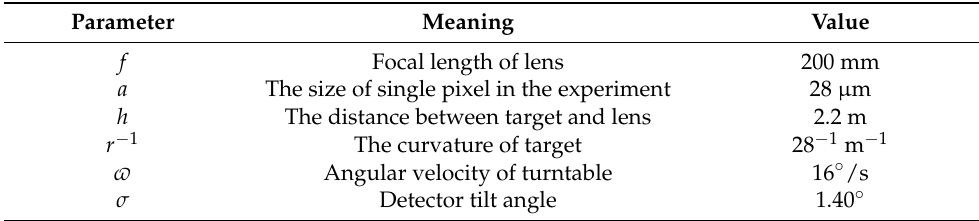
Figure 5. Experimental principle and facilities: ( a ) The imaging principle of experiment; ( b ) The facilities of experiment. Table 2. The parameters in the